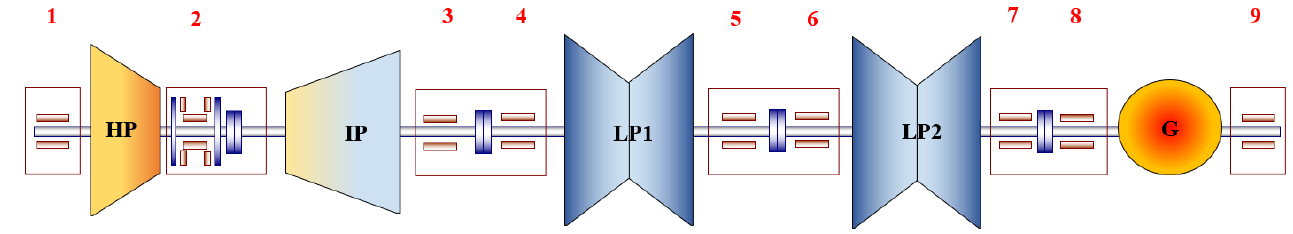
Figure 11. 560 MW steam turbogenerator unit shaft ‐ to ‐ bearing schematic. The LP is the Low ‐ Pressure cylinder.